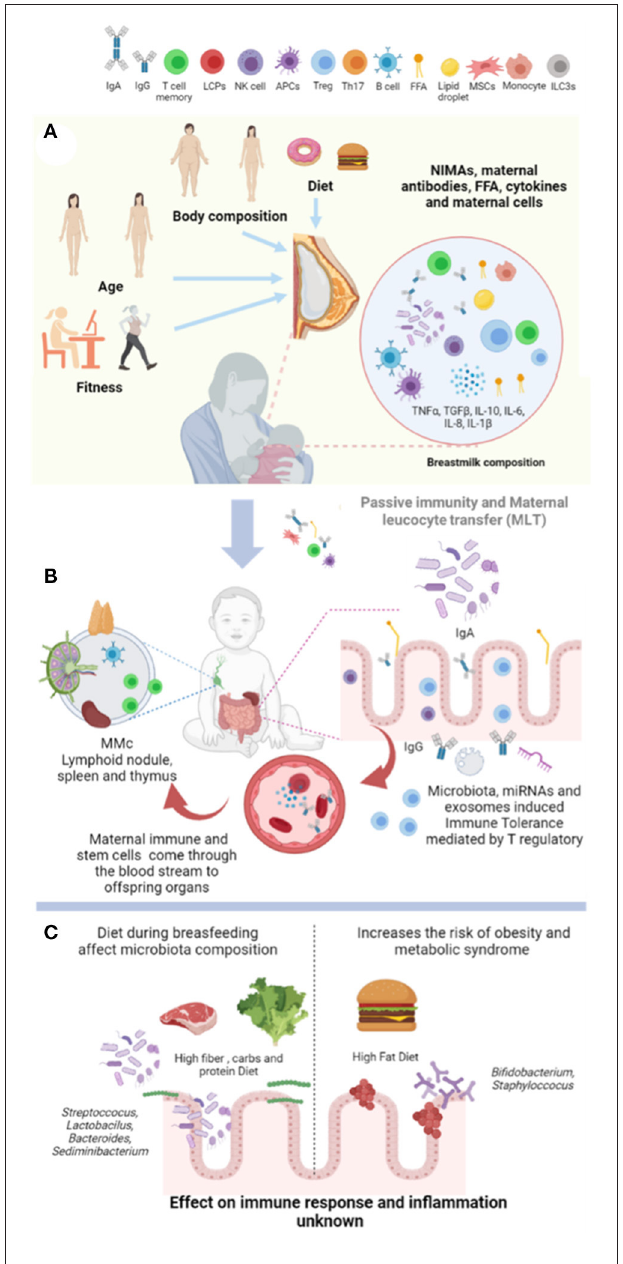
FIGURE 1 | Breastfeeding provides immunological programming in the newborn. (A) Body weight, age, lifestyle, and diet quality influence breast milk composition such as lipid species, microbiota, cytokines, and accumulation of immune cell types. (B) Maternal antibodies, non-inherited maternal antigens (NIMAs), and maternal leucocyte travel through the stomach and intestine of the offspring. Also, maternal immune and stem cells invade the newborn blood leading to maternal microchimerism (MMc) to generate immune tolerance. Finally, microbiota, mRNAi, and exosomes provide immune tolerance by T-cell accumulation in the gut of the offspring. (C) High fat, carbs, and protein diets intake disrupts microbiota composition by promoting Staphylococcus and Bifidobacterium accumulation. Whereas, high fiber, carbs, and protein leads to lactobacillus microbiota. However, the effect of diet during breastfeeding on immune response, MMc, immune tolerance, and offspring microbiota establishment has not been fully determined in humans. NIMAs, non-inherited maternal antigens; MMc, maternal microchimerism. Created by